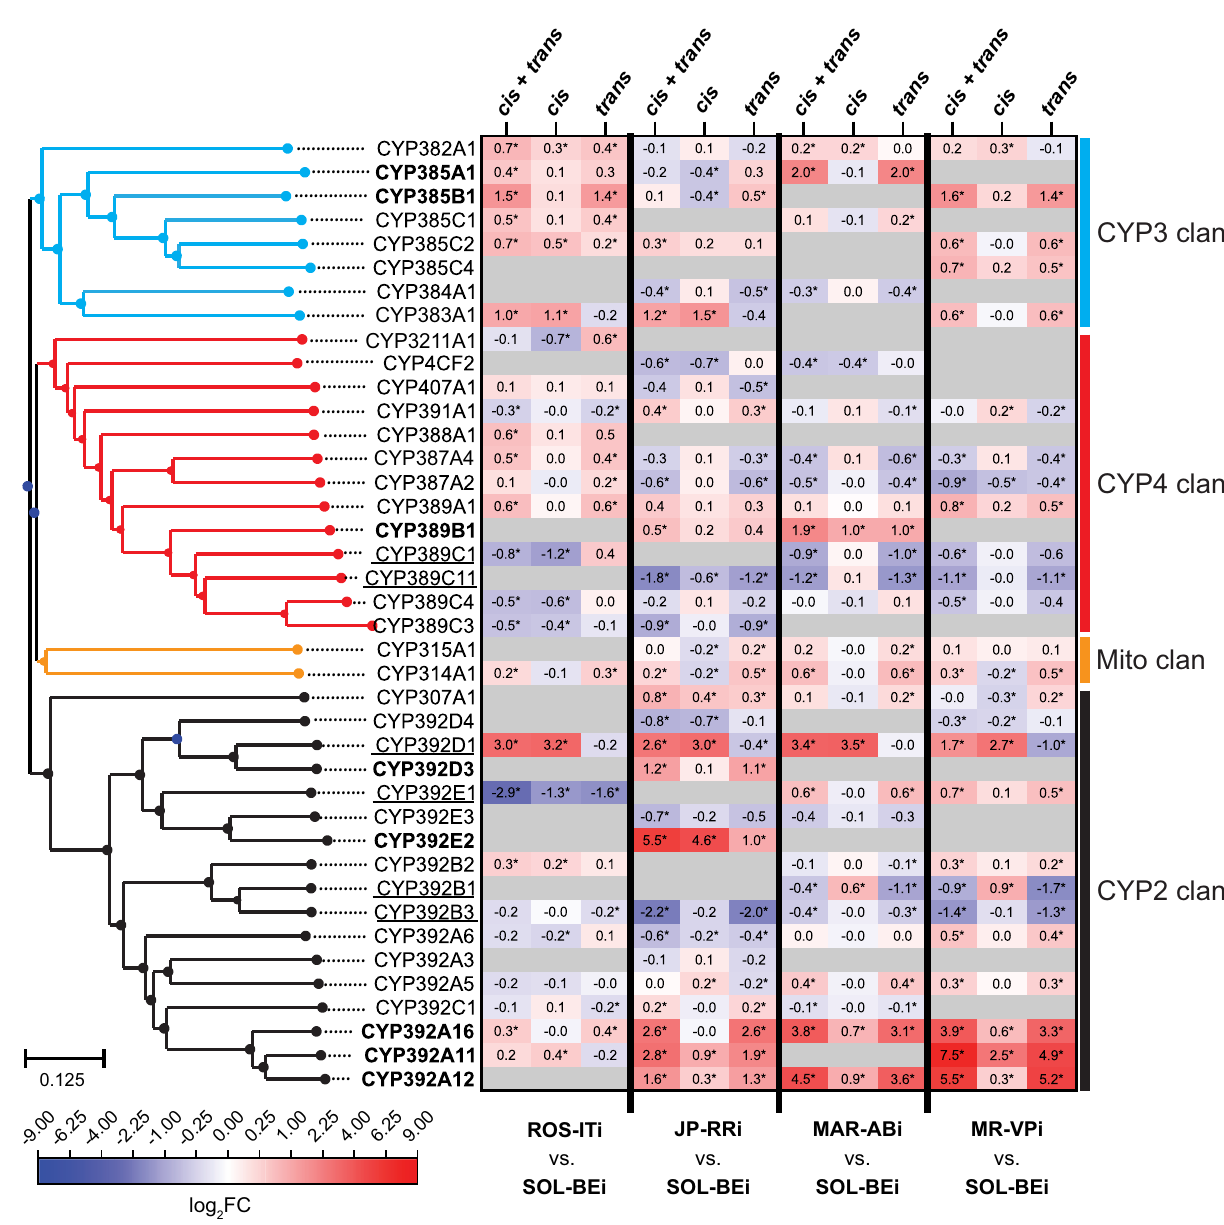
Fig 5. The contribution of cis and trans effects for CYP gene expression variation among pairwise strain comparisons. A heatmap (center right; scale, bottom left) shows log 2 fold change (log 2 FC) values for CYPs between parents (a combination of cis and trans effects, denoted “ cis + trans ”) and for ASE in F1s (which correspond to cis effects); approximations for the magnitude of trans contributions to fold changes were obtained by subtracting cis from cis + trans log 2 FC values (log 2 FC values are given internal to each cell; where significant differential expression between parents was observed, or cis and trans effects were significant, asterisks are used, see Methods and S4 Table). The three groupings are as indicated at the top, and the pairs of strains for the four comparisons are indicated at bottom. Genes with log 2 FC > 1 attributed to trans in at least one of the comparisons are in bold, and genes with log 2 FC < -1 attributed to trans in at least one of the comparisons are underlined. CYP gene names are given to the left, and are ordered based on a neighbor-joining phylogenetic tree (far left). CYP clan membership is indicated at the far right, with clades in the tree color-coded respectively. For inclusion of a CYP in the analysis, a genetic mode of control had to be assigned in at least one comparison. Where information for a gene was not available in a genotypic comparison, cells are colored in gray.